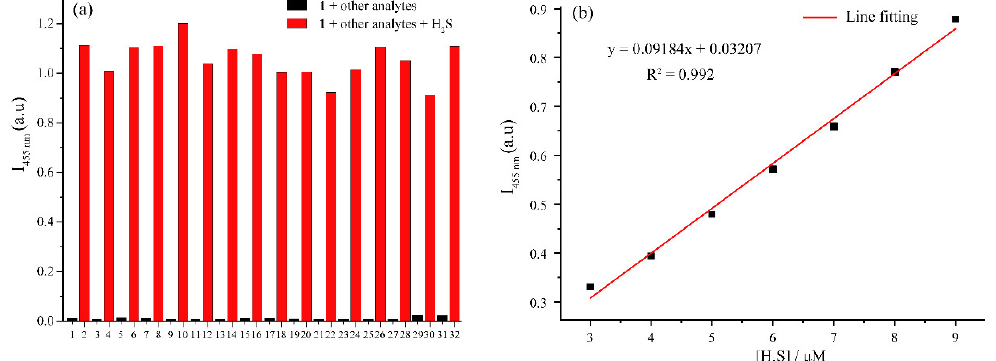
Figure 4. ( a ) Fluorescence intensity at 455 nm of 1 (10 μM) treated with 100 equiv. of various species (black bar) followed by the addition of 10 equiv. of H 2 S (red bad) in the H 2 O-CH 3 CN (1:1, v/v , 10 mM PBS, pH = 7.40) (1: 1 + Ser; 2: 1 + Ser + H 2 S; 3: 1 + Met; 4: 1 + Met + H 2 S; 5: 1 + Leu; 6: 1 + Leu + H 2